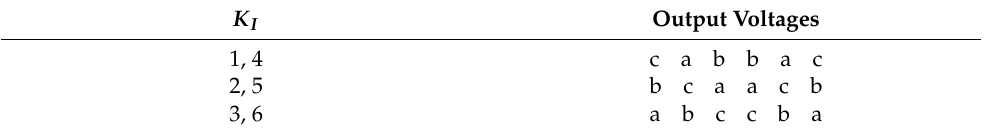
Table 4. Switching sequence of output voltages according to the input current sector. K I